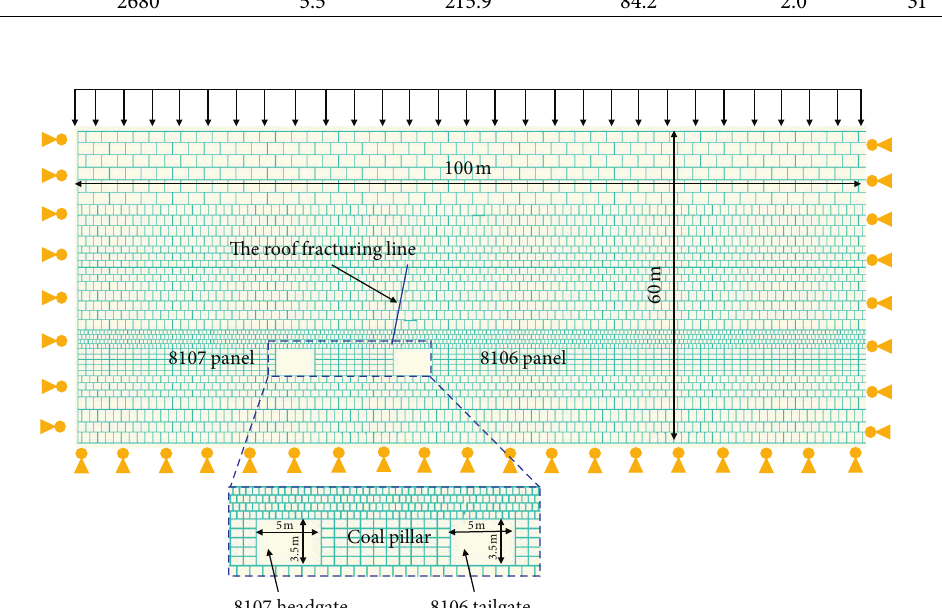
Figure 11: The UDEC numerical model.